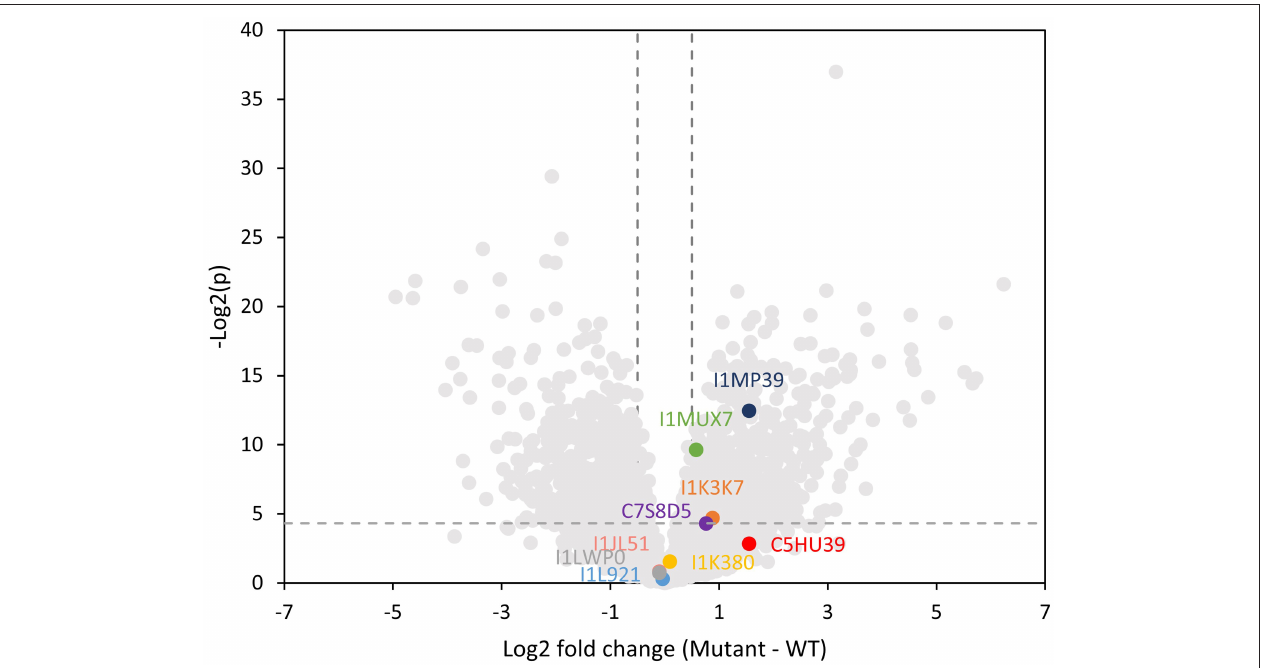
FIGURE 6 | Volcano plot showing log2 fold change in the plant proteome abundance between wild type and mutant soybean nodule. Data points that are above the dashed line [y-value greater than –Log(0.05)] are considered statistically significantly different. Vertical dashed lines mark the 1.4 fold change cutoff (log2 fold change = 0.5). Lewis-a containing glycoproteins are highlighted indicating that three of them are significantly higher abundance in the mutant